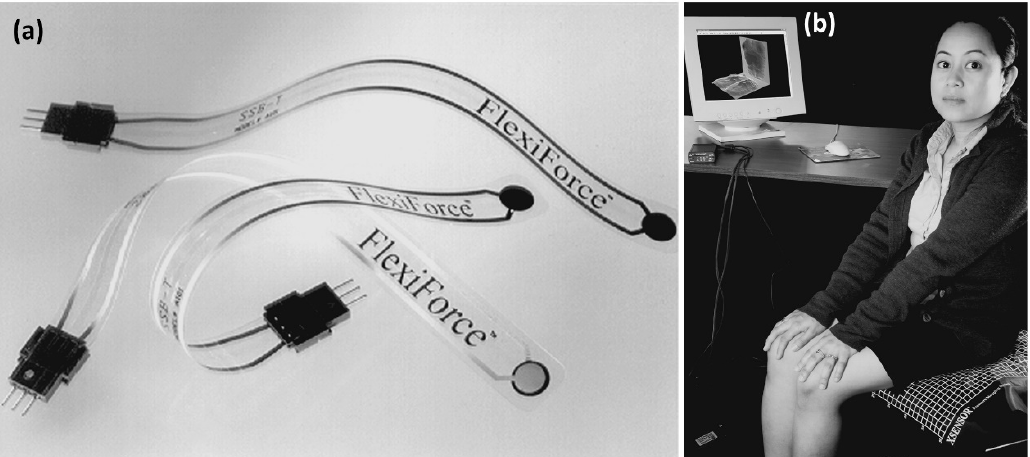
Figure 9. ( a ) Flexible commercial force sensors with a single sensing element are shown having a circular and located at the tip of the flexible plastic strip and ( b ) pressure mapping maps placed on chair sitting face and the back side having the integrated array of sensors, which are linked to a small electronics interface box that is connected to a standard computer. The computer screen shows a real-time image of the pressure distribution. Reprinted/adapted with permission from Ref.